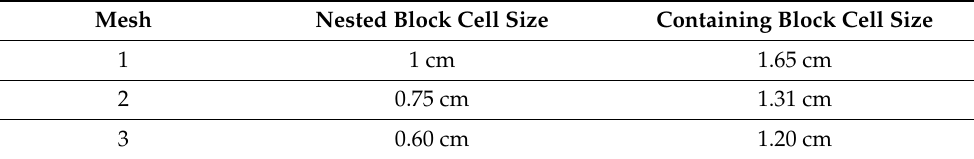
Table 3. Characteristics of the meshes tested in the convergence analysis.